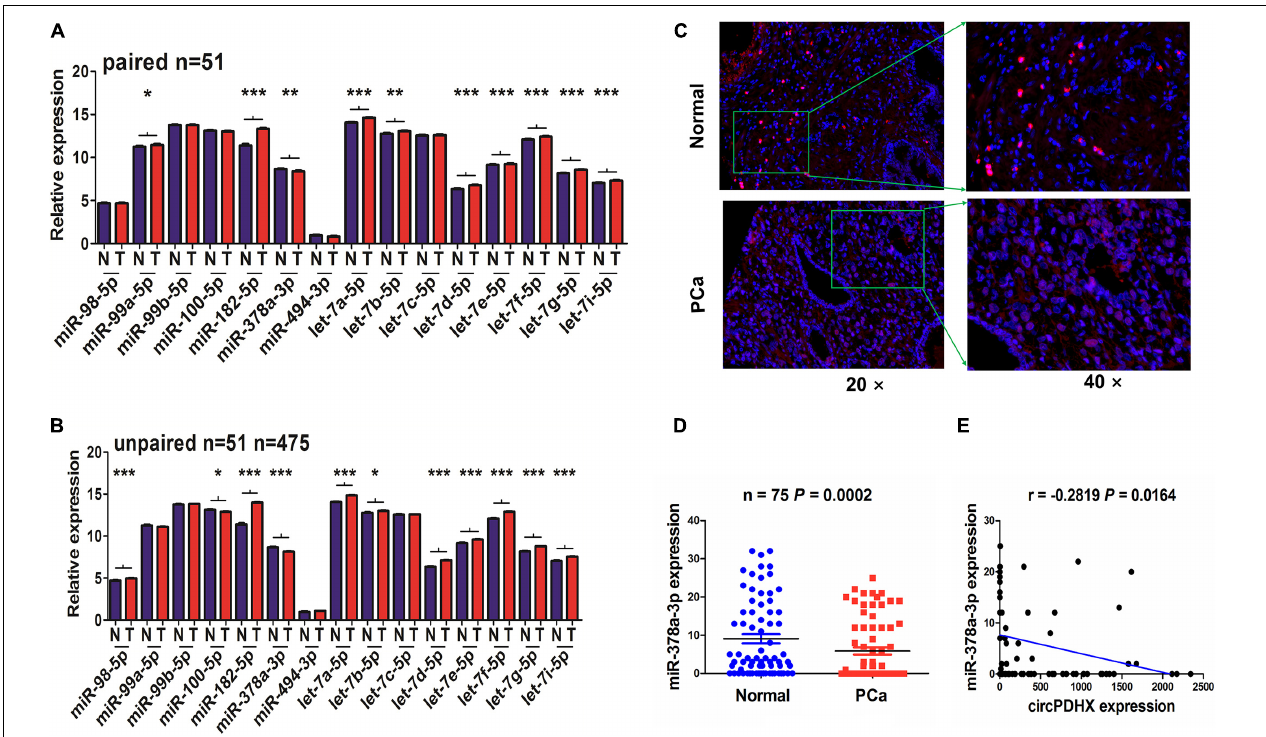
FIGURE 4 | circPDHX had a negative correlation with miR-378a-3p expression in prostate cancer (PCa) tissue samples. (A,B) The Cancer Genome Atlas (TCGA) analysis of the expression levels of 15 miRNAs in paired ( n = 51) and unpaired PCa tissue samples ( n = 475). (C,D) Fluorescence in situ hybridization (FISH) analysis of the expression levels of miR-378a-3p in pair-matched PCa tissue samples ( n = 75). (E) Pearson correlation analysis of the correlation of circPDHX with miR-378a-3p expression in PCa